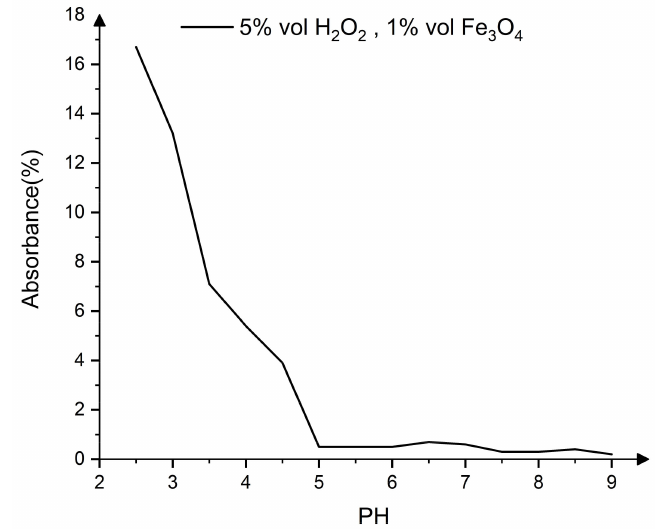
Figure 2. Effect of pH on absorbance.